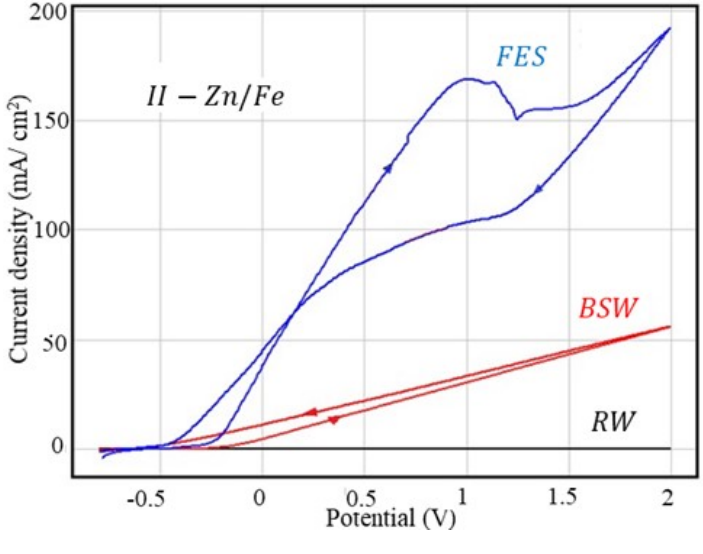
Table 9. Stimulated corrosion parameters for the II-Zn/Fe sample in the corrosive environments.